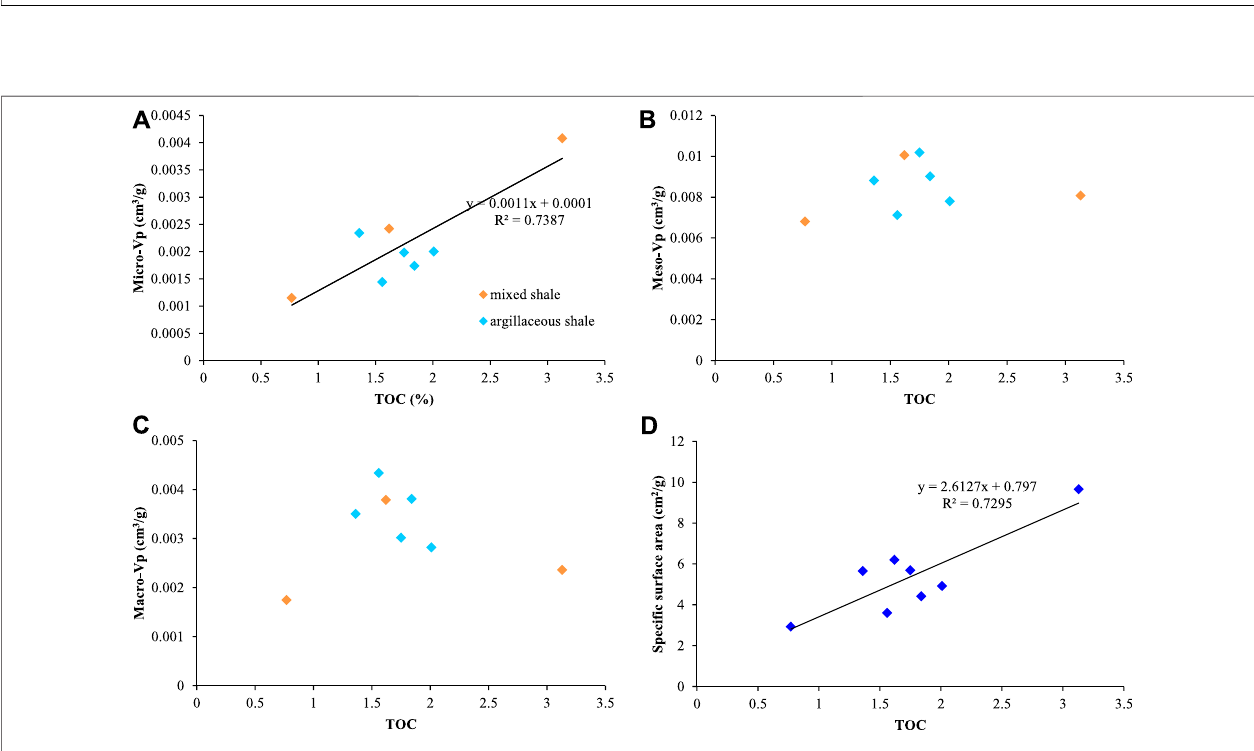
Frontiers in Earth Science |